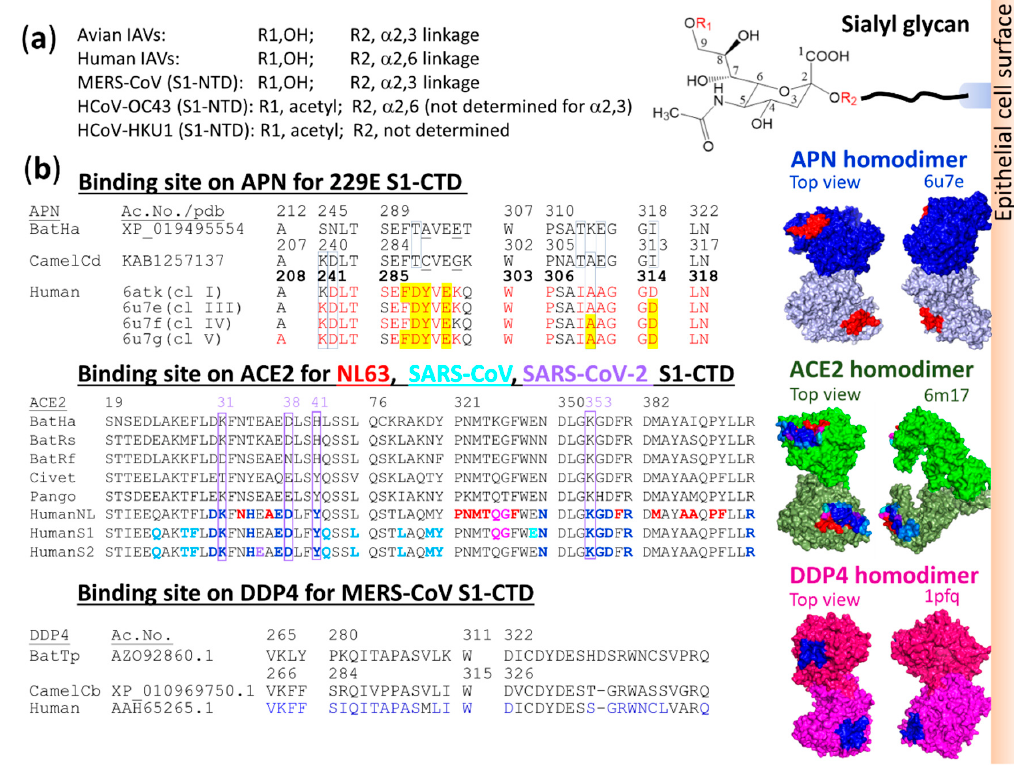
Figure 4. Sialyl glycans and proteins on the epithelial cell surface that are important determinants for IAV and CoV infections. ( a ) Sialyl glycan receptors of IAVs and CoVs. Whereas most IAV HAs prefer the most common Sia, Neu5Ac, over Neu5Gc as a receptor [192], HCoV-OC43 and -HKU1 S1-NTDs recognize Neu5Ac modified with an O -acetyl group at the C9-position (R1), Neu5,9Ac 2 [92,193]. It is well known that sialyl linkage at the C2-position (R2) is a key host determinant of IAVs and that change of their binding preference from α 2,3 to α 2,6 is a critical factor of avian-to-human host switch [10]. In contrast, there has not been sufficient study on the linkage specificity of HCoV-OC43 and -HKU1 binding, although it is known that HCoV-43 can bind to Neu5,9Ac 2 α 2,6Gal β 1,4GlcNAc (9- O -Ac-6SLN) [193]. Distinct from β 1CoVs, additional O -acetylation at the C7 or C9-position to Neu5Ac impedes the binding of MERS-CoV ( β 3CoVs) [112]. Like avian IAV HAs, MERS-CoV S1-NTD prefers Neu5Ac linked to α 2,3 over α 2,6 [148]. ( b ) Protein receptors of CoVs. Only virus binding site (VBS), receptor amino acids covering the area of the interface between the protein receptor and the indicated viral S1-CTD, are colored. Ac. No., accession number; BatHa, Hipposideros armiger ; camelCd, Camelus dromedaries , batHa, Hipposideros armiger (Ac.No., XP_019522954.1); batRs, Rhinolophus sinicus (Ac.No., AGZ48803.1); batRf, Rhinolophus ferrumequinum (Ac.No., XP_032963186.1); civet, Paguma larvata (Ac.No., AAX63775.1); pangolin, Manis javanica (Ac.No., XP_017505752.1); human ACE2 (Ac.No., ACT66268); NL, NL63; S1, SARS-CoV; S2, SARS-CoV-2; batTp, Tylonycteris pachypus ; camelCb, Camelus bactrianus . Right: Sialyl glycan structure and top view and side view of surface diagrams of protein receptors. VBSs are colored according to the aa sequences on the left-hand side. 6u7e, 6m17, 1pfq are from [194–196],